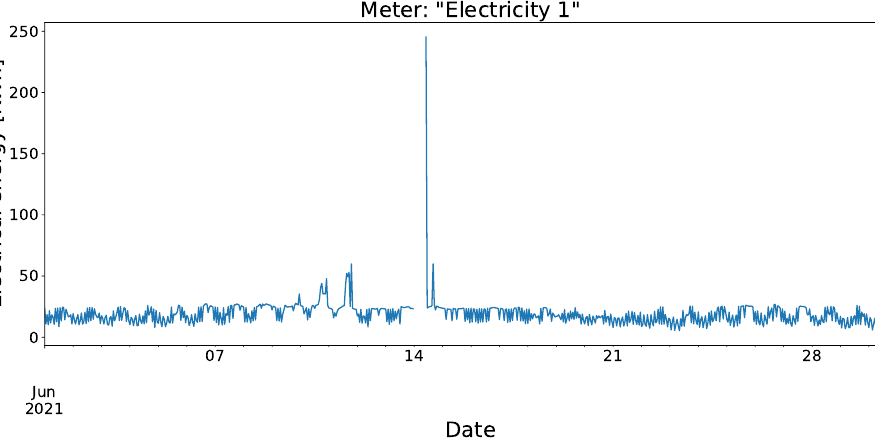
Figure 9. Detail of technical failure in readings (hourly sampled) received by meter “Electricity 1”. Other analyses were also carried out on the data, to understand its behavior over